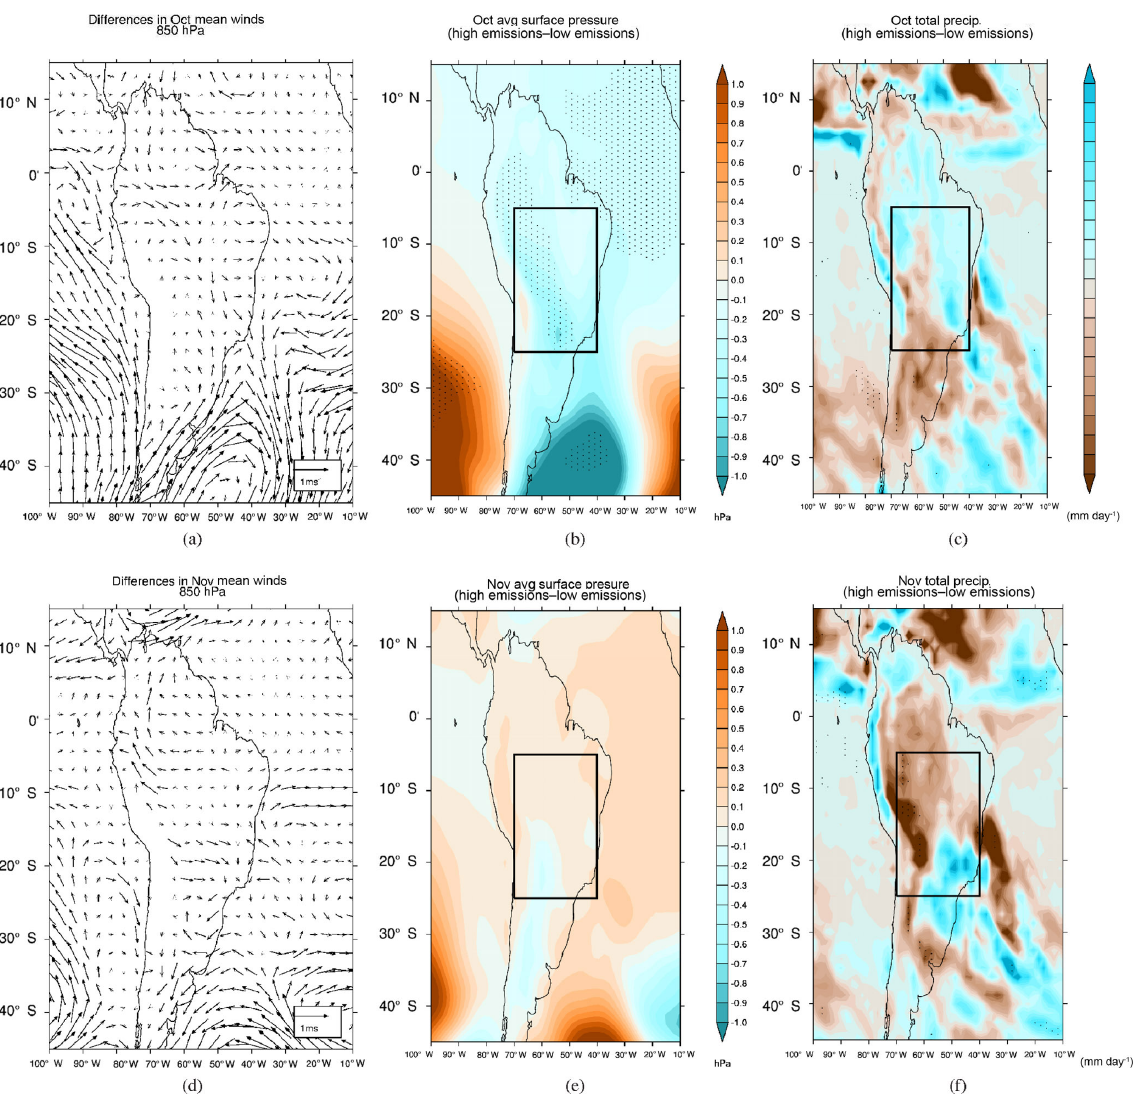
Figure 17. Plot showing the differences in meteorological variables for October and November: (a) differences in mean circulation for October; (b) differences in mean surface pressure for October; (c) differences in mean precipitation for October; (d) differences in mean circulation for November; (e) differences in mean surface pressure for November; (f) differences in mean precipitation for November. (Note the difference in projection and area from previous